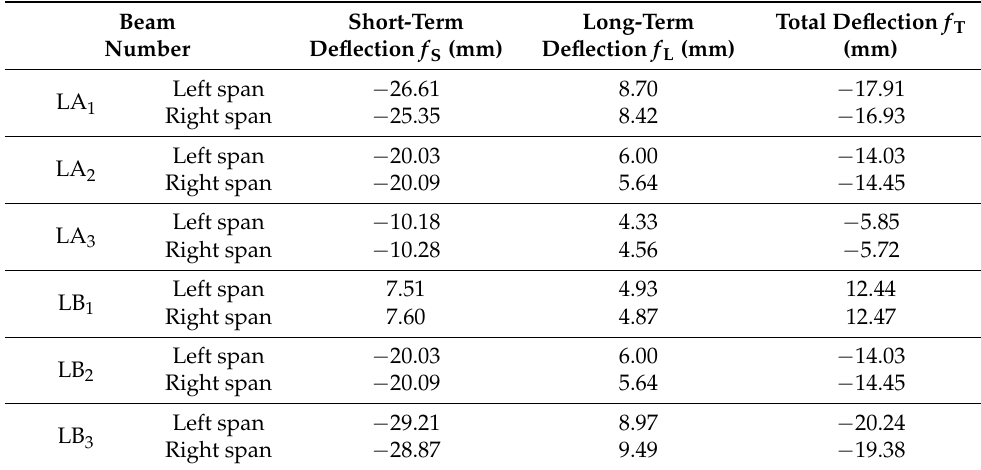
Figure 11. Deformation diagram of the prestressed glulam continuous beam during loading. Table 4. Midspan deflection value of prestressed glulam continuous beams.